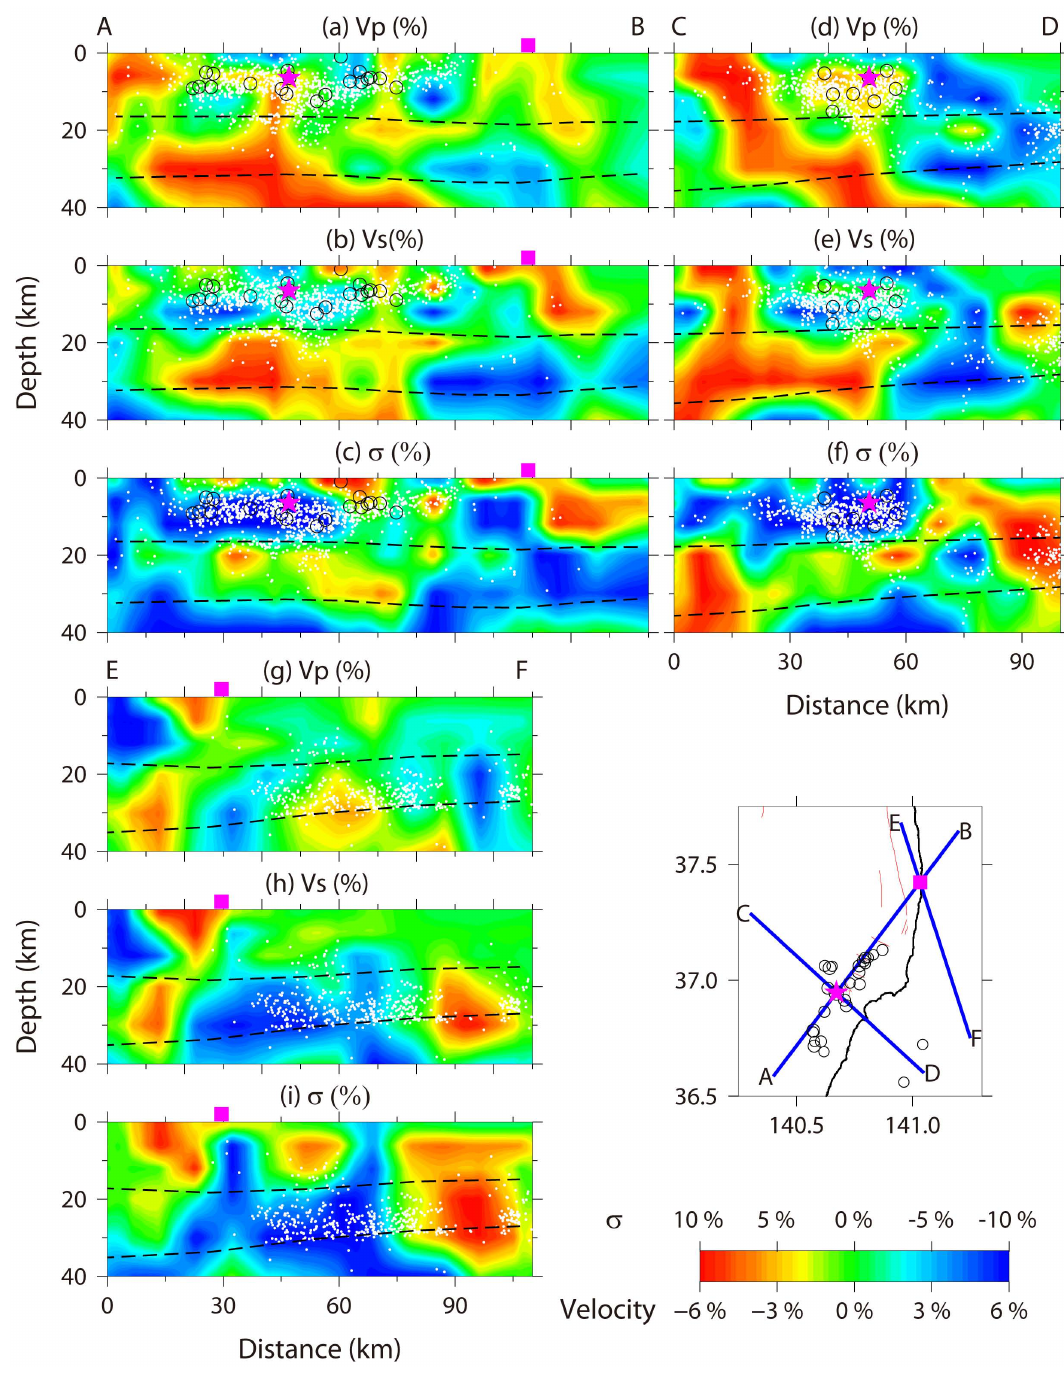
Fig. 5. Vertical cross-sections of P wave velocity, S wave velocity, and Poisson’s ratio images obtained with the finite-frequency tomography method along the lines AB (a–c) , CD (d–f) and EF (g–i) as shown on the inset map. The vertical exaggeration is 1:1. Small white dots denote the events (most are the aftershocks of the Iwaki earthquake) during 11 March 2011 to 27 October 2011, which are located within 8-km width along each profile. The star symbols denote the Iwaki mainshock (M 7.0) hypocenter at 6.4km depth, while the open circles show the relatively large Iwaki aftershocks (M > 5.0). The square symbols represent the Fukushima nuclear power plant. The two dashed lines denote the Conrad and Moho discontinuities. Red color denotes low velocity and high Poisson’s ratio, while blue color represents high velocity and low Poisson’s ratio. The scales for the velocity and Poisson’s ratio perturbations (in %) are shown at the bottom.